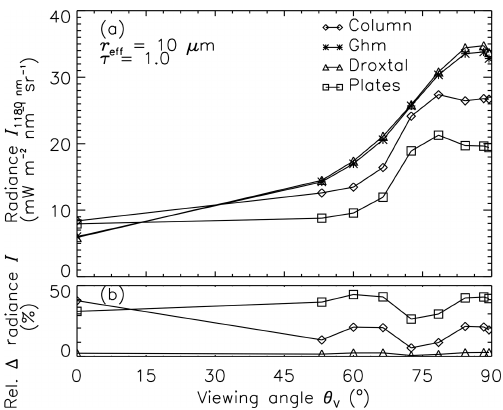
Figure 6. Simulated radiance I V at λ = 1180nm wavelength RTS , 1180 for different ice crystal shapes as a function of the viewing angle θ V of the sensor (a) . In Panel (b) the relative differences in simulated radiance with respect to the reference shape “Ghm” are presented for the other three ice crystal